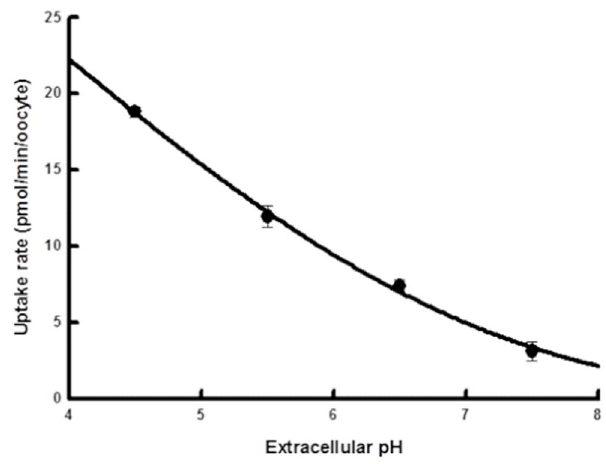
Figure 1. Accumulation of L-lactate in hMCT4-expressing oocytes. Oocytes were incubated for various periods at 25 u C with transport buffer of pH 5.5 or pH 7.5 containing 0.1 mM L-lactate. Control oocytes were injected with the same volume of water instead of hMCT4 cRNA. Each point represents the mean 6 S.E. of three – five experiments.